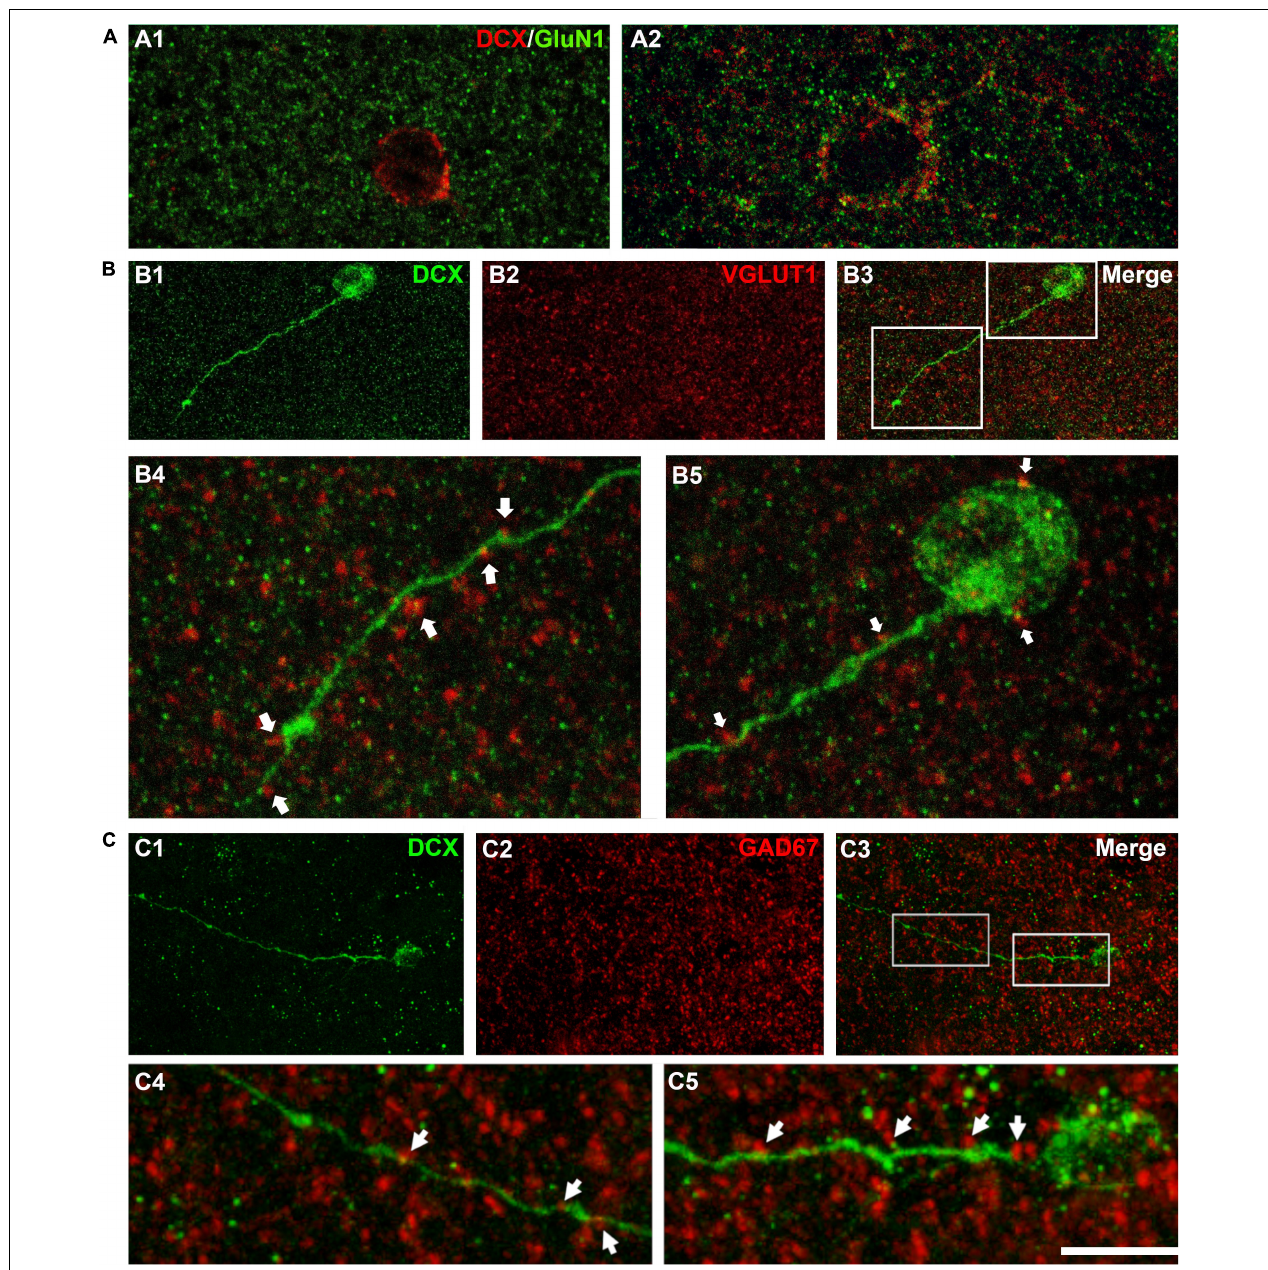
FIGURE 3 | Expression of NMDA receptors (GluN1) and apposed puncta expressing VGLUT1 and GAD67 on DCX immunoreactive cells. (A) Confocal microphotographs of the temporal cortex showing the expression of GluN1 in small type I (A1) and larger type I DCX + cells (A2) . (B) DCX immunoreactive type II cell (green) in the occipital cortex layer II showing puncta expressing the excitatory marker VGLUT1 (red) apposed to its soma and dendrite (arrows). (C) DCX immunoreactive type II cell (green) in the temporal cortex layer II. Note the presence of GAD67 expressing puncta (red) apposed to its soma and dendrite (arrows). (A1) Is a single confocal plane, (A2,B,C) are 2D projections of 4 (A2) 9 (B) and 12 (C) consecutive confocal stacks (0.38 µ m apart). Scale bar: 10 µ m for (A,B4,B5,C4,C5) ; 40 µ m for (B1–3,C1–3) . All confocal images in this figure were from neurosurgical samples.